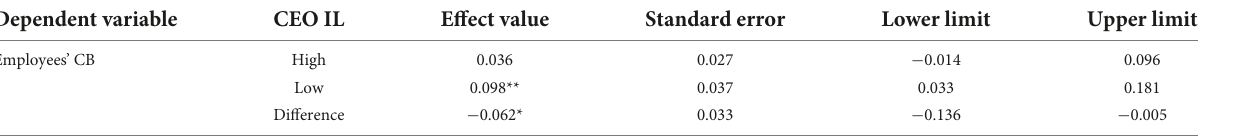
TABLE 4 Monte Carlo simulation tests the moderated mediating